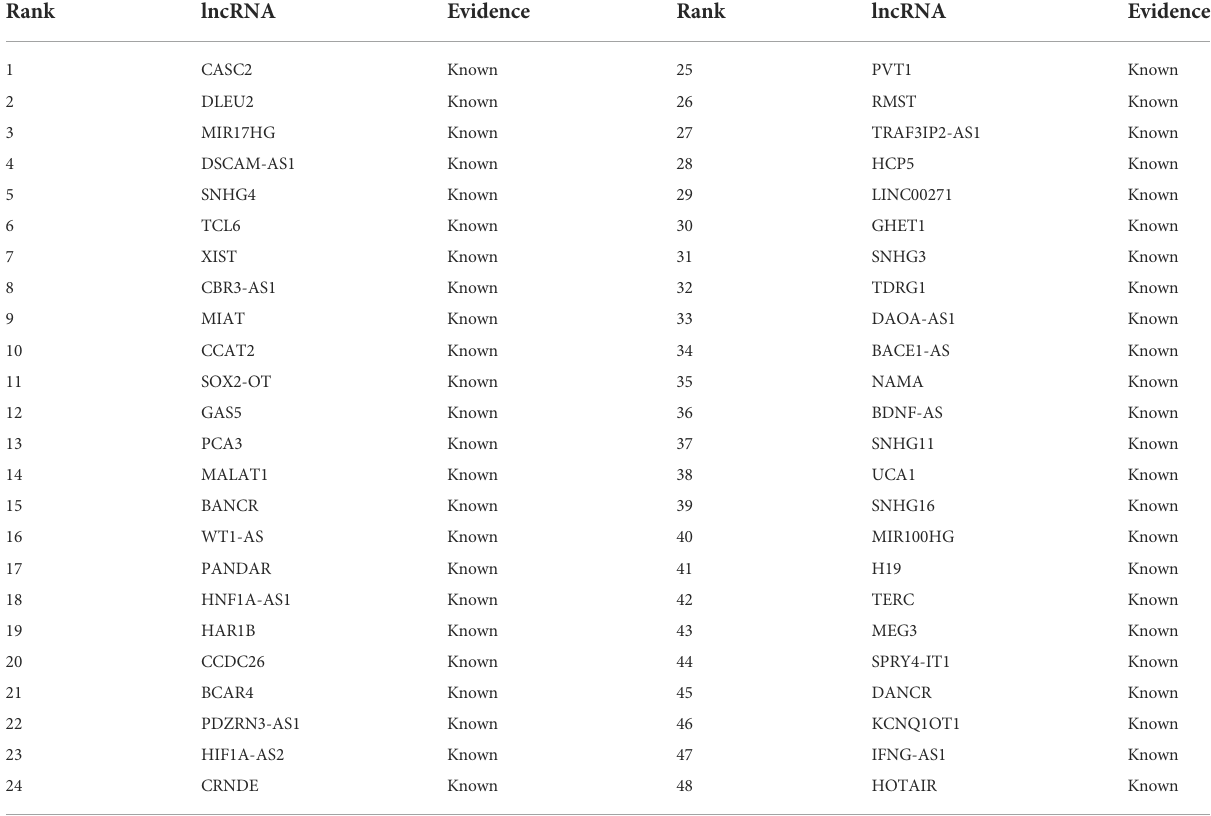
TABLE 2 The rankings of the predicted top 48 lncRNAs according to association with breast cancer on the MNDR dataset. Rank